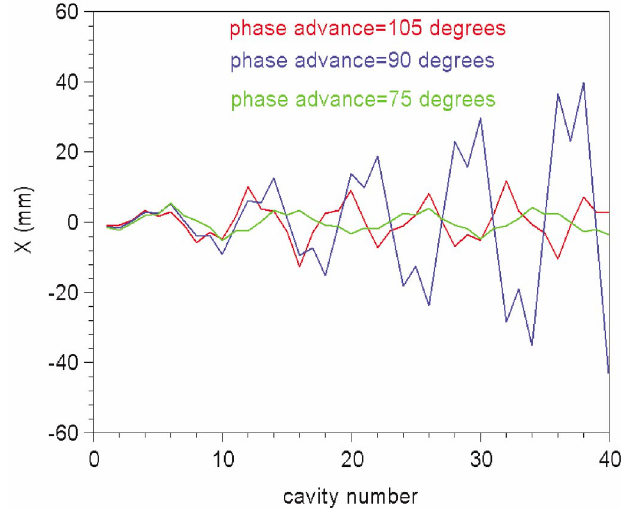
FIG. 14. (Color) Trajectories in the horizontal plane at different phase advance.